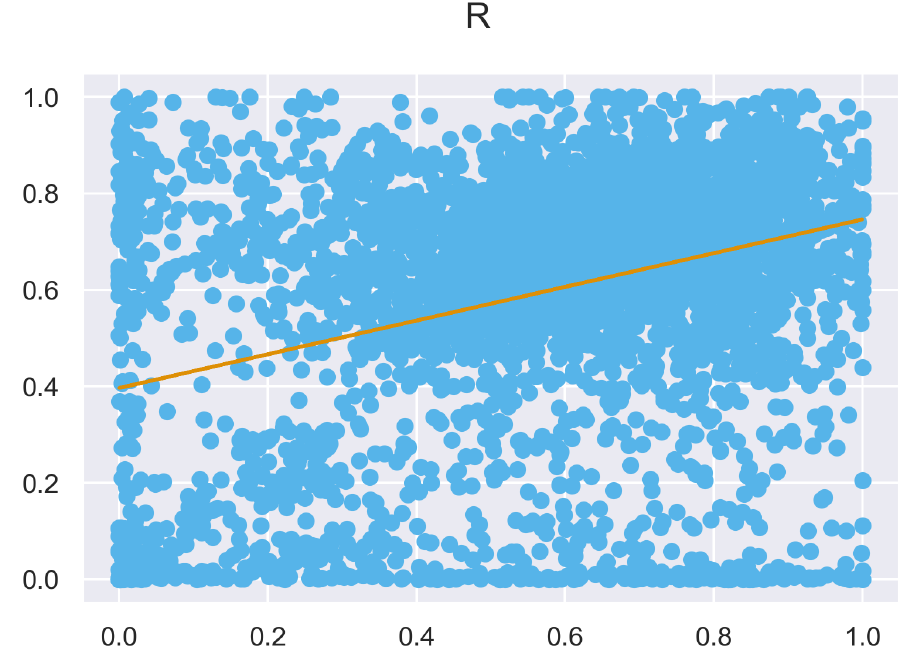
Figure A32. ULS and TLS R regression at 1m grid size.